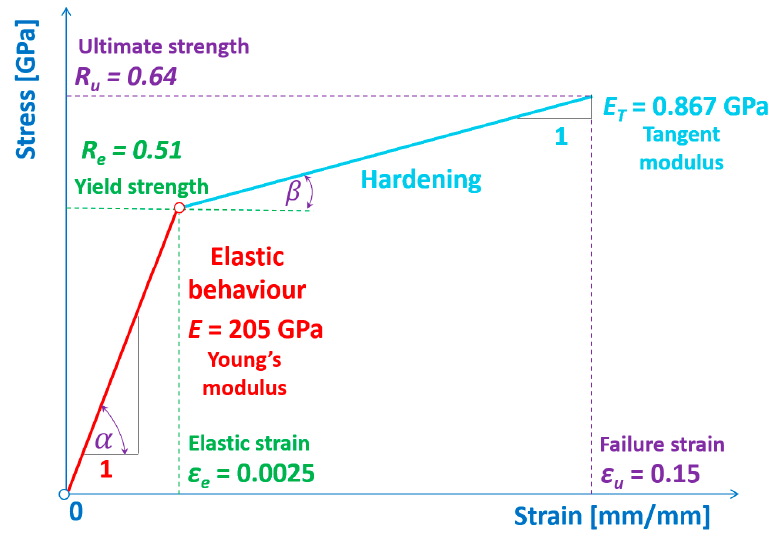
Figure 1. Constitutive bilinear elastic plastic material model of an ultra-thin sheet being cut.